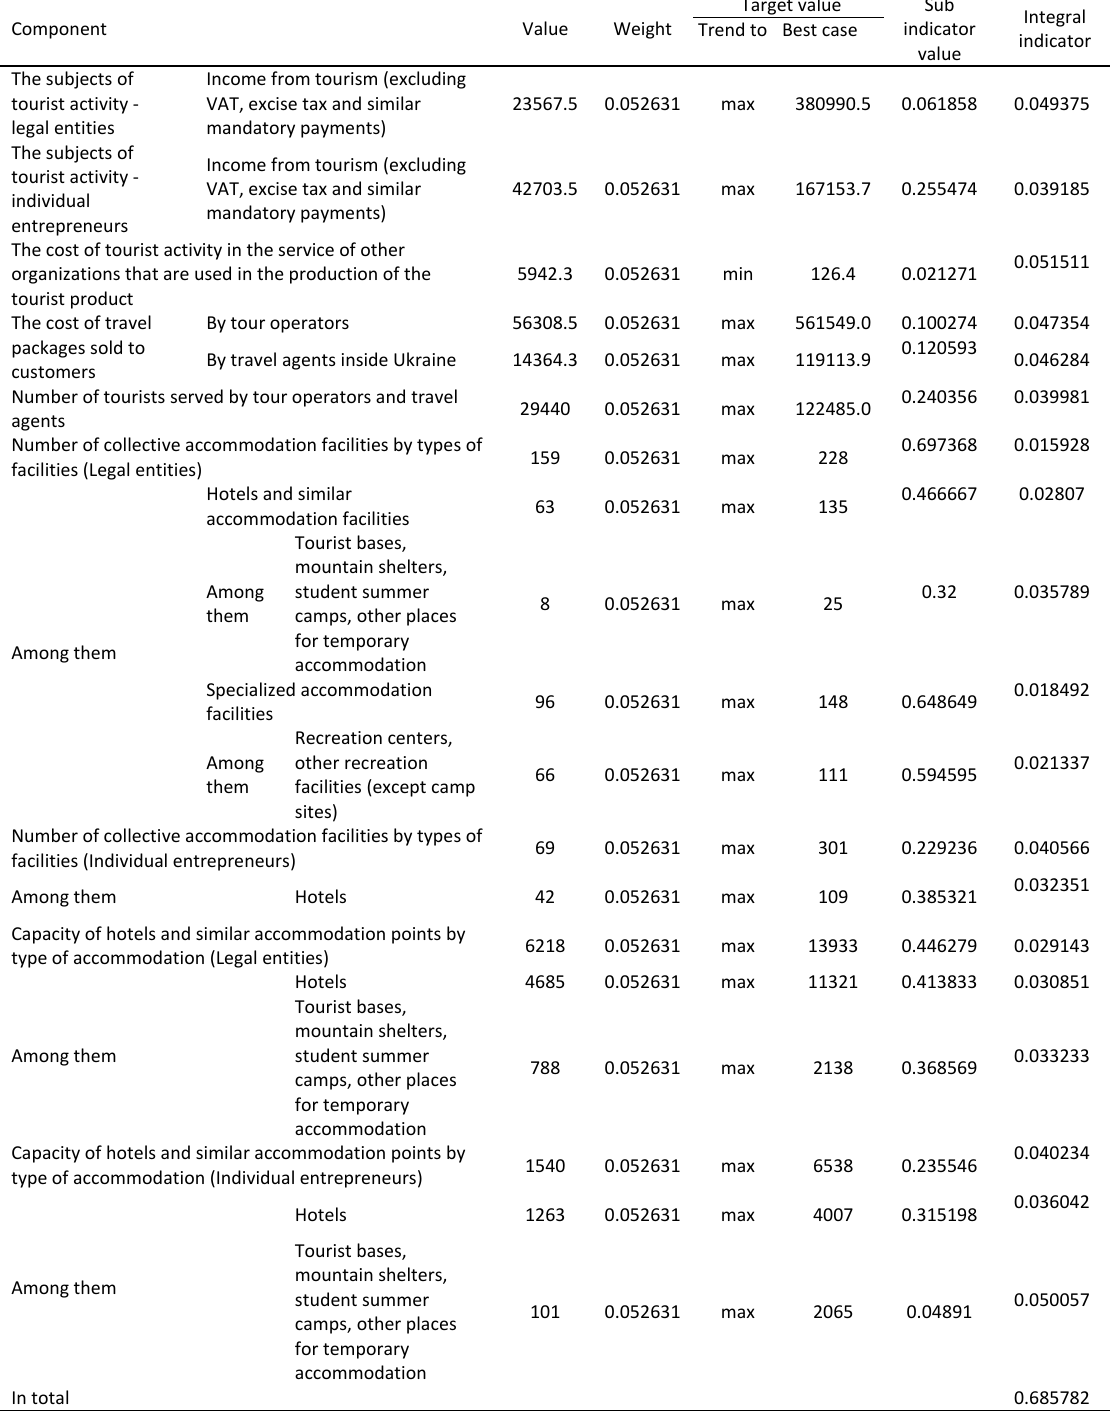
Table 3: Calculations of the integral indicator of the tourism competitiveness: Dnipropetrovsk region casein 2020